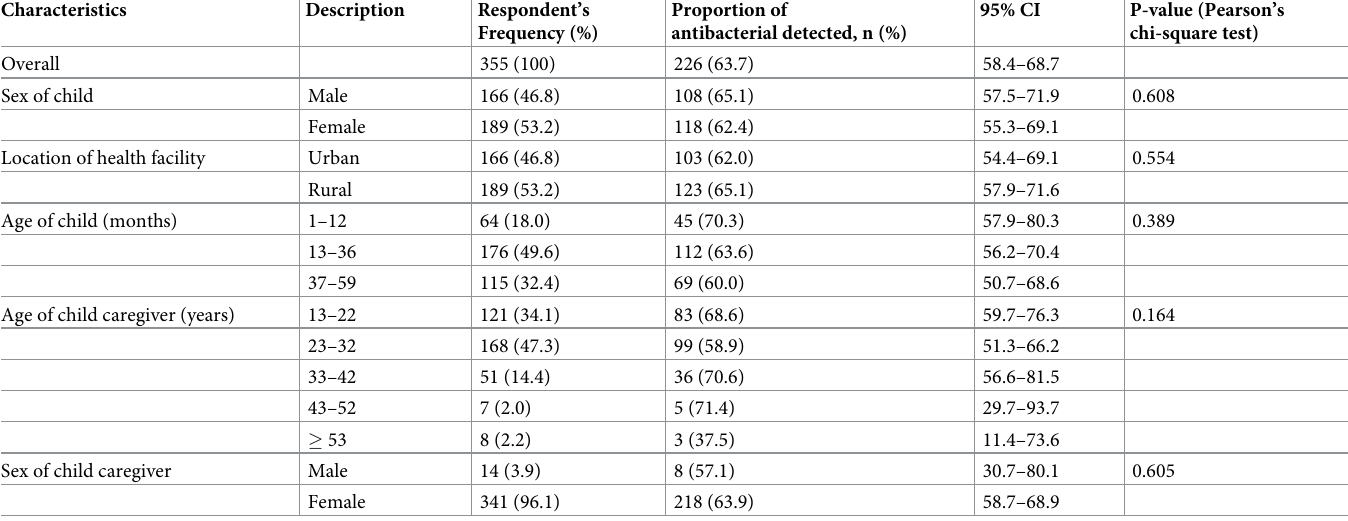
Table 2. Prevalence of antibacterials detected in blood or urine samples of children under five years in rural communities of Gulu district, northern Uganda (August, 2019).